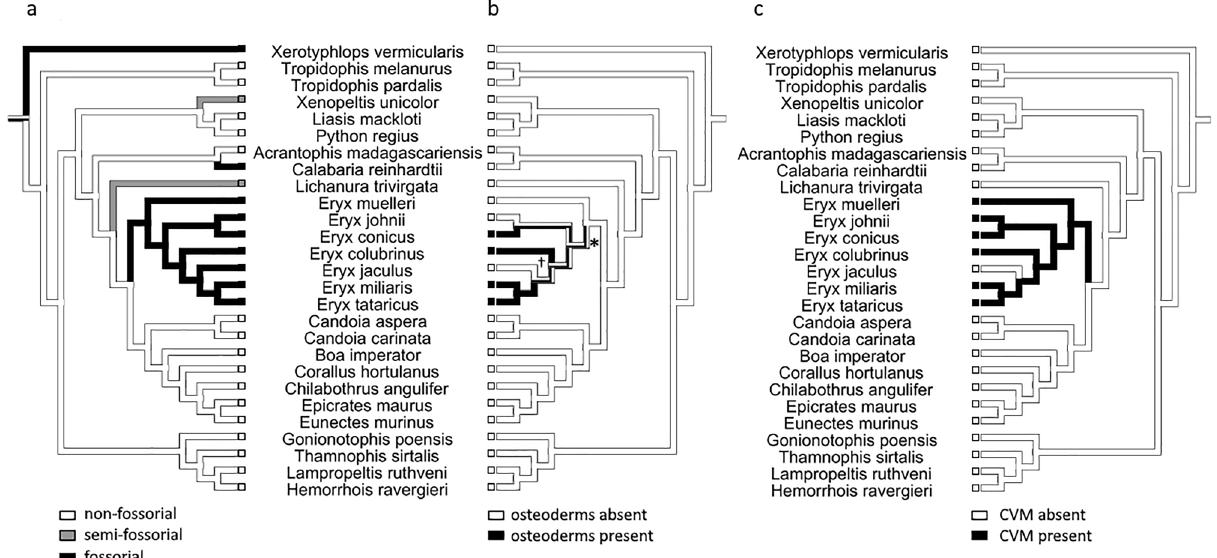
Figure 4. Visualisation of ecology, osteoderms and caudal vertebrae modifications on the phylogenetic tree. ( a ) fossoriality, ( b ) presence of osteoderms, and ( c ) presence of caudal vertebrae modifications (CVM) in snakes. Ancestral state reconstruction using maximum parsimony following the topology of Reynolds et al. 2014 was employed in Mesquite. Abbreviations: * the putative origin of dermal armour in sand boas, † the possible uncertainty of presence/absence of osteoderms due to the low sample size of E. jaculus. Author: Petra